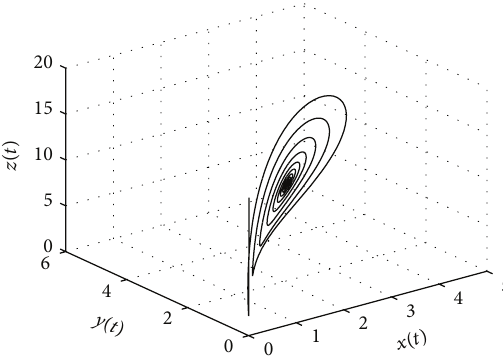
Figure 16: Chaos occurs for the fractional general 𝑇 system (6) when 𝑏 1 = 40.